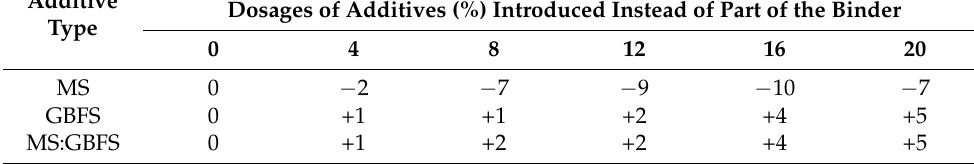
Table 13. Change in the thermal conductivity coefficients of non-autoclaved aerated concrete de- pending on the type of additive and its dosage.